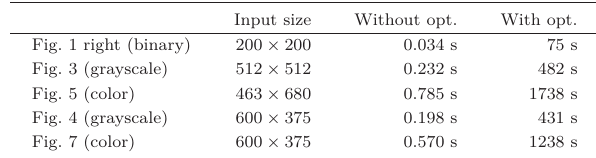
Table 4 Time taken for EVCSwithCommonShare with and without optimization Input size Without opt. With opt. Fig. 1 right